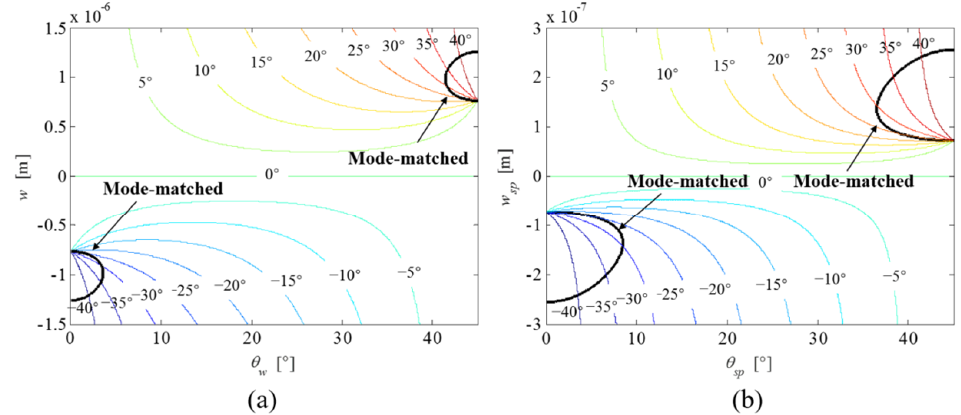
Figure 5. The influence of width variation of both the ring ( a ) and the supporting beams ( b ) on the principal axis of the 2 θ mode pair, which is represented by contour maps. The black curved lines indicate the mode-matched solutions.